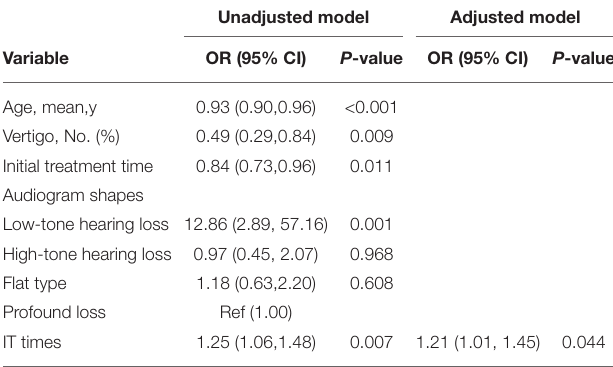
TABLE 3 | Potential factors associated with hearing